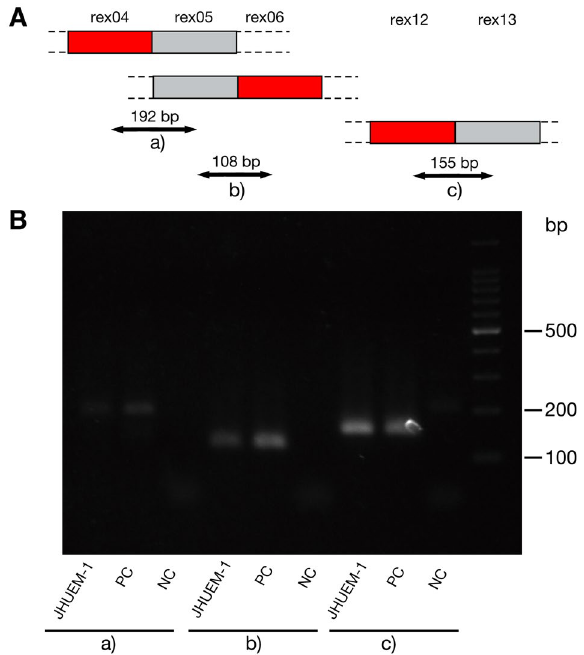
Figure 4. PCR amplification of novel exons. ( A ) Schematic representation of PCR amplicons. ( B ) Electrophoresis of the PCR amplicons. PC and NC indicates synthesized positive and negative controls shown in Table S6. ( a )–( c ) indicate the amplicons in ( A ). Full-length image of the gel is included as Fig.